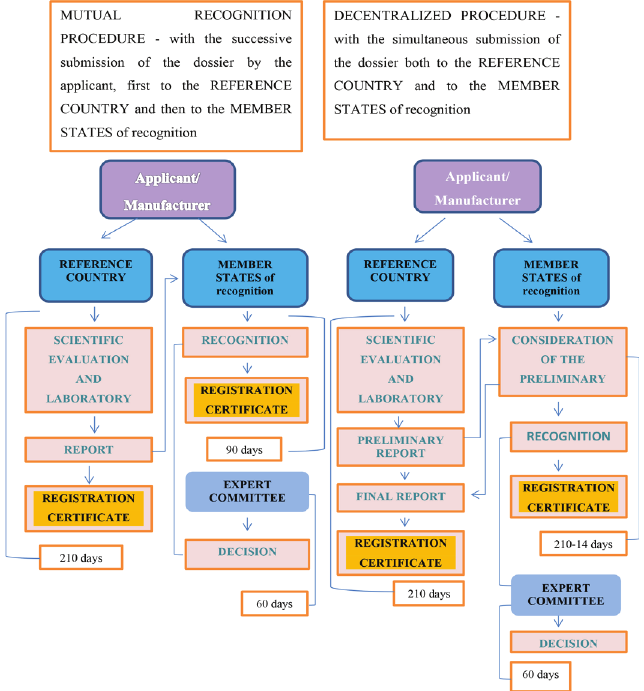
Figure 2 - Registration Procedures for Medicines in the